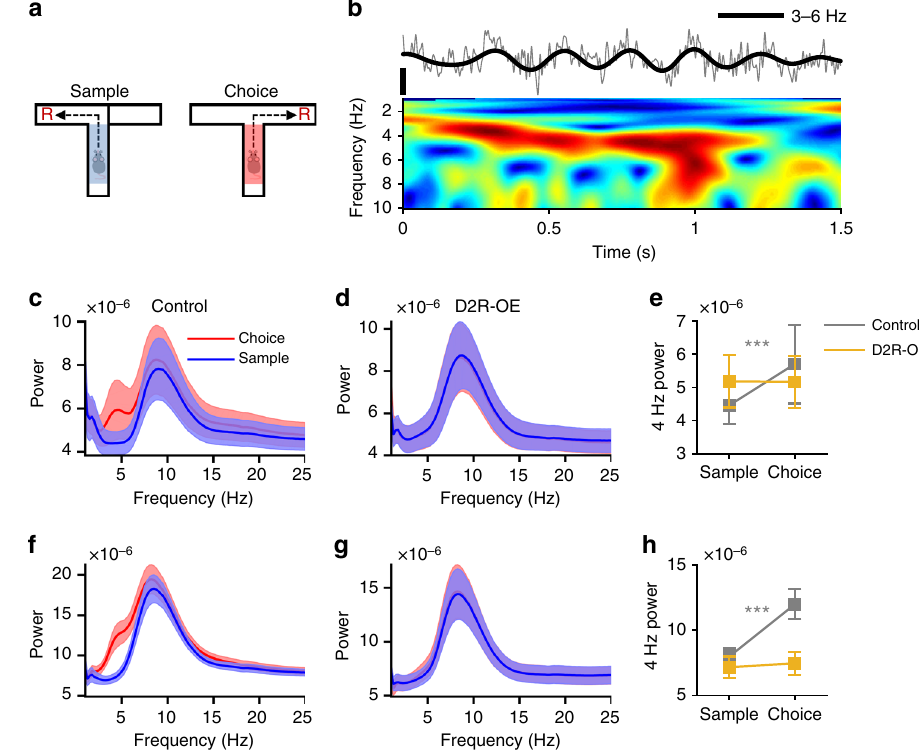
Fig. 2 Impaired recruitment of 4 Hz oscillations in the VTA and PFC during working memory in D2R-OE mice. a Neural activity was compared in the center arm of the maze in the sample (blue) and choice phases (red). Overt behavior is the same in both phases but working memory is only required in the choice phase. b Example LFP trace recorded in the VTA (top) during the choice phase and its spectrogram (bottom). Note the presence of 3 – 6 Hz oscillations, referred to as “ 4 Hz ” oscillations, which can also be observed in the fi ltered LFP trace (thick lines). Scale bar: 100 µ V. c , d Average spectral power in the VTA during the sample and choice phases for control ( c ) and D2R-OE ( d ) mice. e Average strength of 4 Hz oscillations (calculated by averaging power between 3 and 6 Hz) during sample and choice phases in the two groups. Four Hertz oscillations were stronger during the choice phase in the VTA of control animals ( n = 19, *** p < .001, sign-rank test) but not in D2R-OE mice ( n = 17, p = 0.79, sign-rank test). f – h Four Hertz power in the PFC of control and D2R-OE mice during sample and choice phases, shown as in c – e . 4 Hz oscillations were stronger during the choice phase in the PFC of control animals ( n = 19, *** p < .001, sign-rank test) but not in D2R-OE mice ( n = 17, p = 0.18, sign-rank test). Shaded regions and error bars represent mean ± s.e.m over